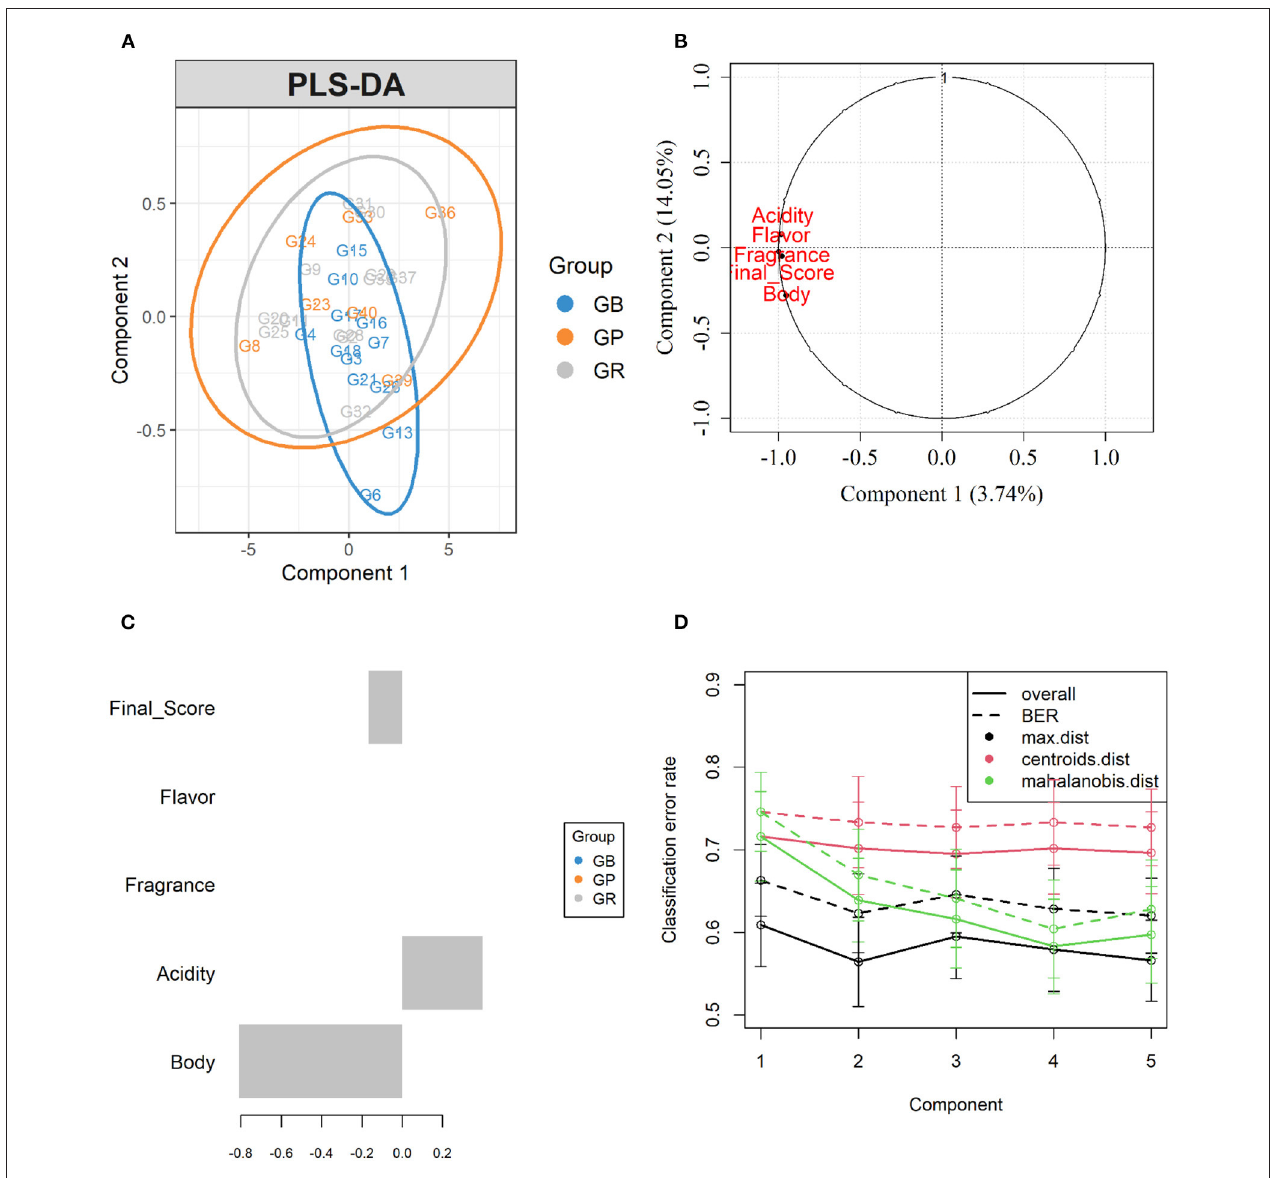
FIGURE 4 | (A) Graph of the PLS-DA scores of two components for sensory analysis differentiating the genealogical groups. ( ) GB—Bourbon Group, ( ) GP—Paraíso Germplasm, ( ) GR—Resistant Cultivars Group. (B) Correlation Graph of sensory attributes with components 1 and 2 with classes GB, GP and GR. (C) Loads of component 2 of the PLS-DA model of sensory attributes for each genealogical group. (D) Classification error rate generated for the components of the PLS-DA model through a cross-validation procedure using five parts (5-fold) of the data set to adjust the model and the rest to test it in 100